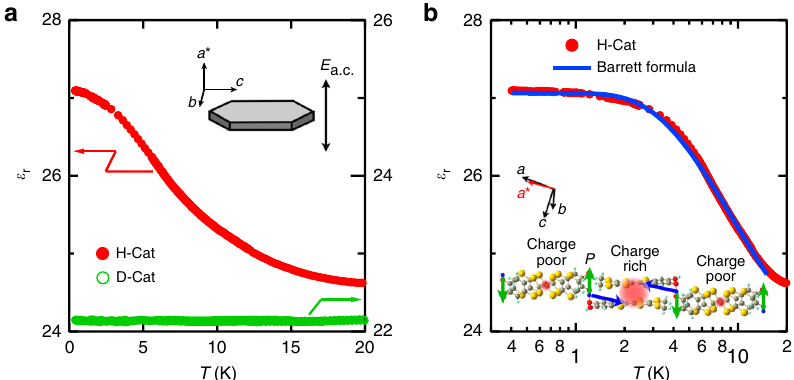
Fig. 2 Dielectric permittivity of H-Cat and D-Cat. a Temperature dependence of the dielectric constant ϵ r ( T ) = ϵ / ϵ 0 in H-Cat (red, left axis) and D-Cat (green, right axis), where ϵ is the dielectric permittivity and ϵ 0 is the vacuum permittivity. The inset illustrates our measurement con fi guration. The dielectric permittivity was measured by applying an a.c. electric fi eld ( E a.c. ) of 1 kV/cm with a frequency of 1 MHz along the a * axis. The sample, d.c. bias and frequency dependence of the dielectric behavior is discussed in Supplementary Note 1 (see also Supplementary Fig. 1). b The same data for H-Cat plotted on a logarithmic temperature scale. The solid line is a fi t to the Barrett formula (see the main text), demonstrating the emergence of a QPE state in H-Cat. The inset shows the electric dipole moments induced within the deuterium bonds and the Cat-EDT-TTF dimers in D-Cat. Because of deuterium localization, the adjacent deuterium bonds possess the local electric dipoles oriented in antiparallel directions (green arrows) below T c . Concomitantly, charge disproportionation is induced within the Cat-EDT-TTF dimers (Fig. 1d), giving rise to the local electric dipoles (blue arrows). Thus, the antiferroelectric interactions are induced by the hydrogen/deuterium-bond